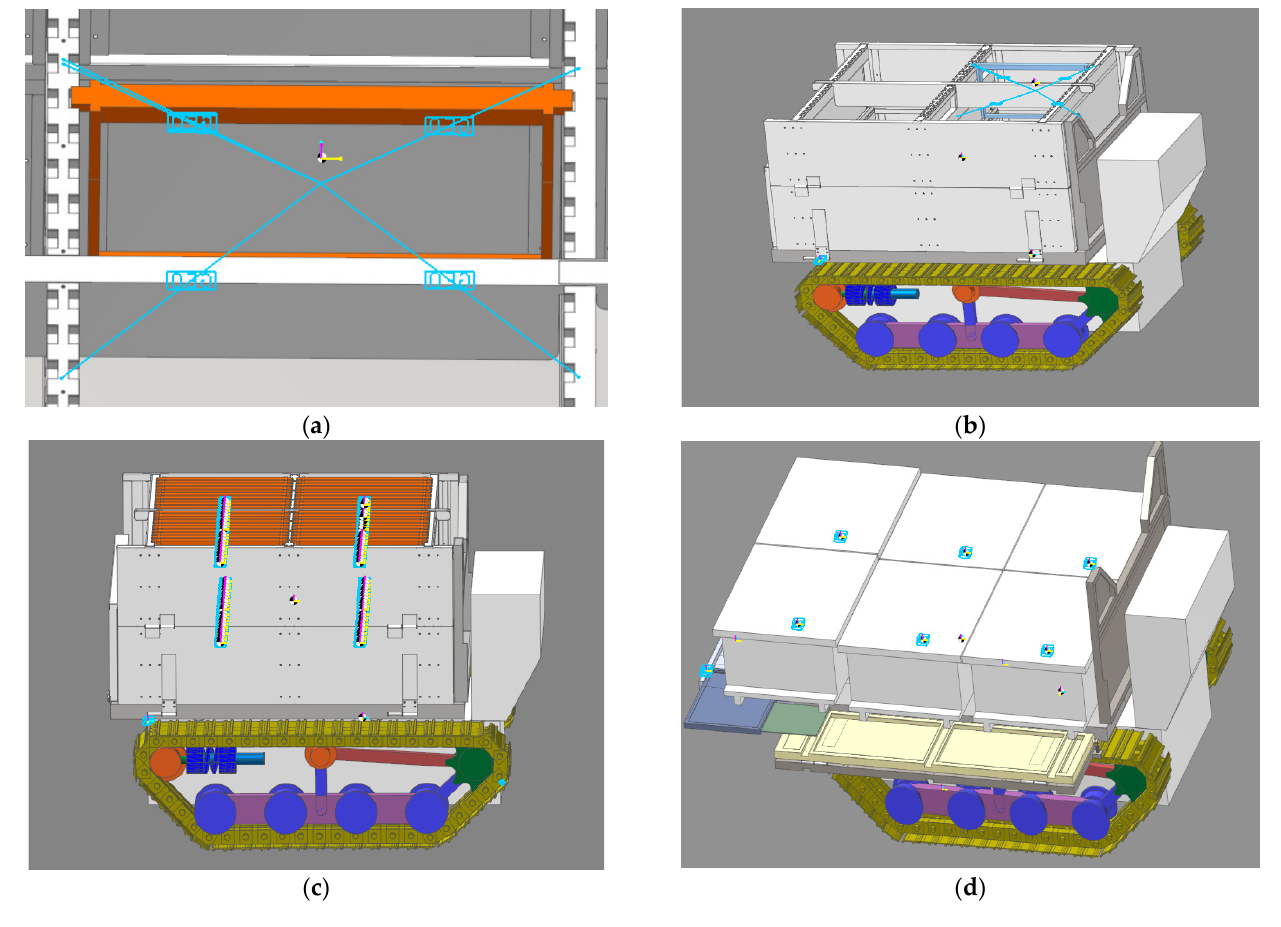
Figure 5. ( a ) Enlarged view of contact relationship between bee frames and interior of loading box, ( b ) tracked vehicle with a single bee frame loaded onto it, ( c ) tracked vehicle fully loaded with bee frames, and ( d ) tracked vehicle fully loaded with beehives.